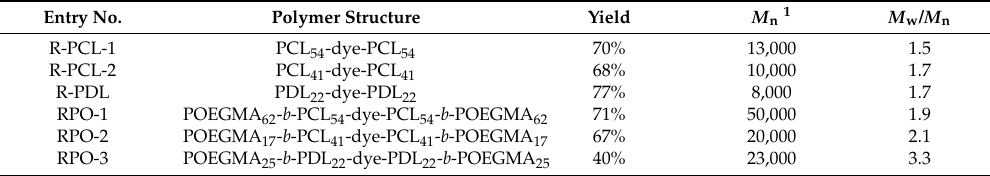
Table 1. Summary of polymer